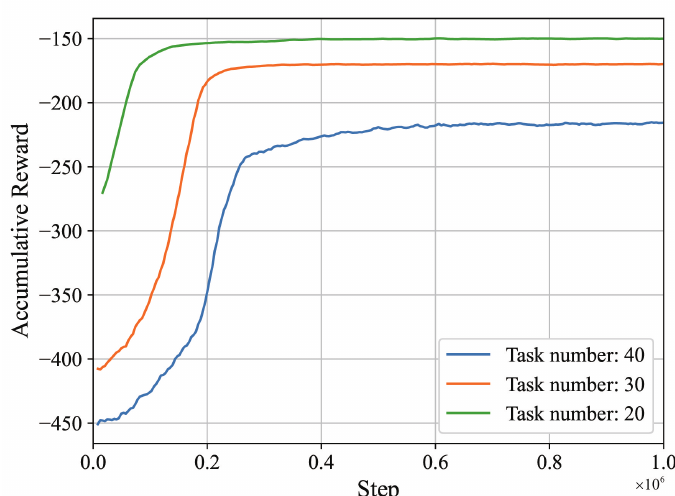
Figure 3. Convergence of PPO resource